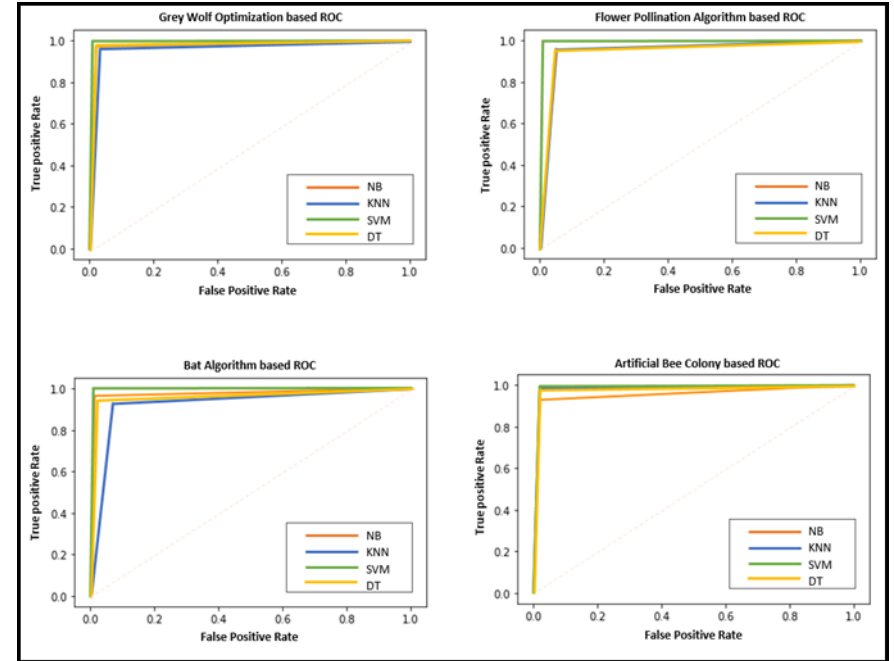
Figure 7. ROC curves of the proposed models on the GE dataset.